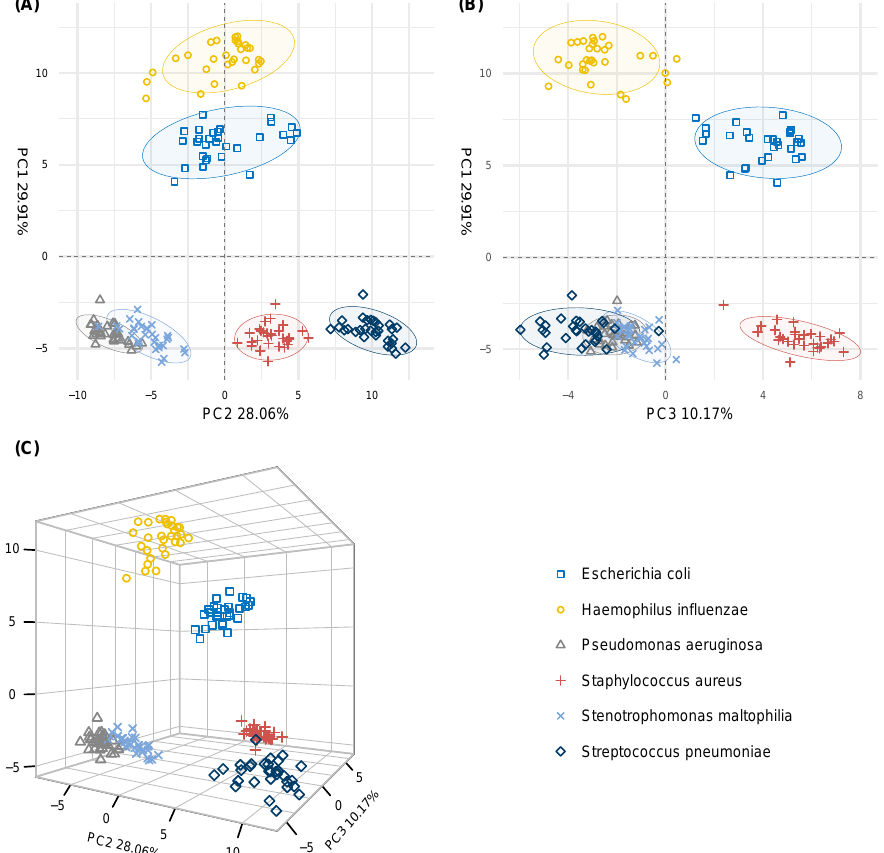
Figure 2. Principal component scores plots of the 6 pathogen groups generated by the extracted 128 m / z -representants. ( A ) PC scores plot of PC1 (29.91%) and PC2 (28.06%), ( B ) PC scores plot of PC1 and PC3 (10.17%) and ( C ) three-dimensional representation of the first three principal components scores. Squares: E. coli , circles: H. influenzae , triangles (point up): P. aeruginosa : plus signs: S. aureus , cross marks: S. maltophilia , diamonds: S. pneumoniae . Colouring was added based on pathogen labels; 90% data ellipses were added ( A , B ) for better visual